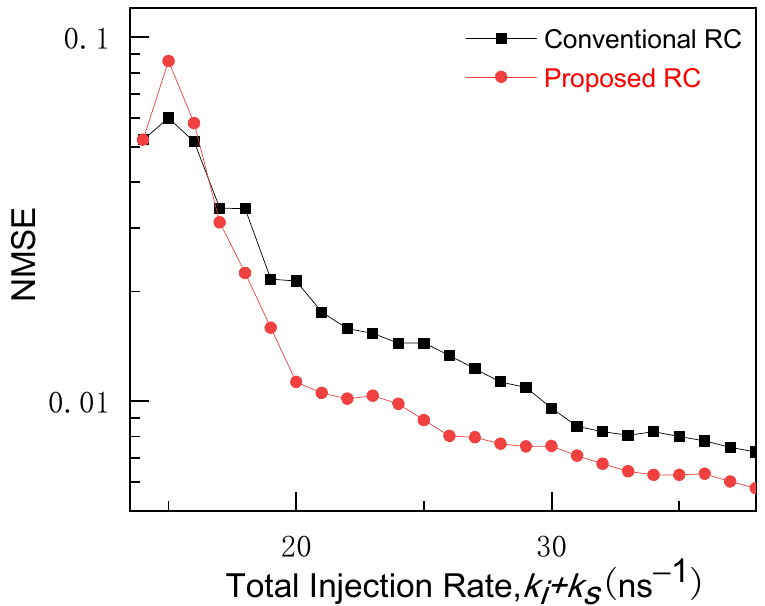
Figure 4. Measured NMSE as a function of total injection rate k i + k s for conventional (black) and proposed (red) RCs. The data from conventional RC are obtained by setting k i = 0. The data from proposed RC are obtained by setting k s = 14 ns − 1 and ∆ ν i = ∆ ν s .